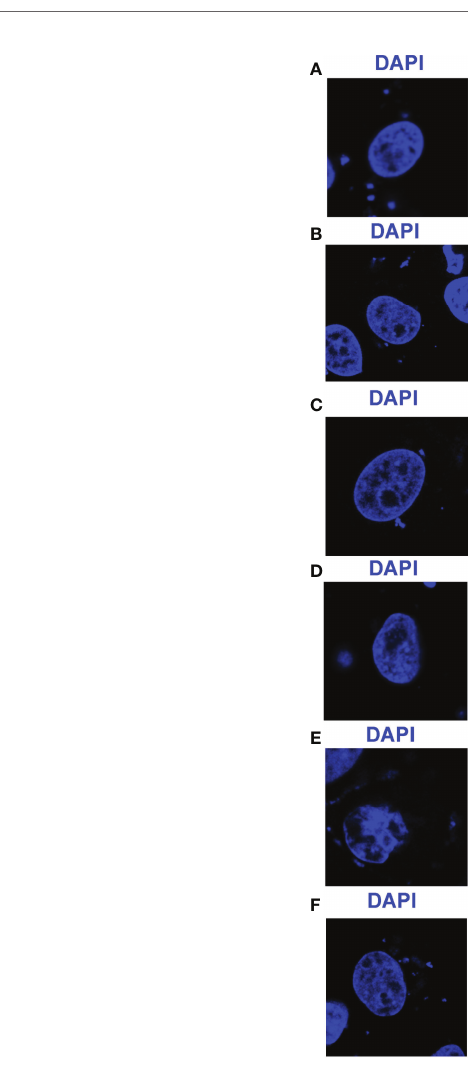
FIGURE 4 | The cellular co-localizations between ASFV p17 and the related proteins of cGAS-STING pathway. 3D4/21 cells grown on glass coverslips in 24-well plate (1.5×10 5 cells/well) were co-transfected with dsRed-p17 (0.5 m g) plasmids plus GFP-STING (0.5 m g) (A) , cGAS-HA (0.5 m g) (B) , IFI16-HA (0.5 m g) (C) , Myc- IKK ϵ (0.5 m g) (E) and p65-HA (0.5 m g) (F) , respectively, as indicated. HA tagged proteins were stained with rabbit anti-HA antibody and Alexa Fluor plus 488 anti- rabbit second antibody. Myc-IKK ϵ was stained with rabbit anti-Myc antibody and Alexa Fluor plus 488 anti-rabbit second antibody. Endogenous TBK1 was stained with rabbit anti-TBK1 antibody and Alexa Fluor plus 488 anti-rabbit second antibody (D) . GFP and dsRed expressions in cells were directly visualized by confocal microscopy. The cellular co-localizations of dsRed-p17 protein with various cGAS-STING pathway proteins in 3D4/21 cells was visualized by confocal fl uorescence microscopy. The arrow illustrates the co-localized puncta